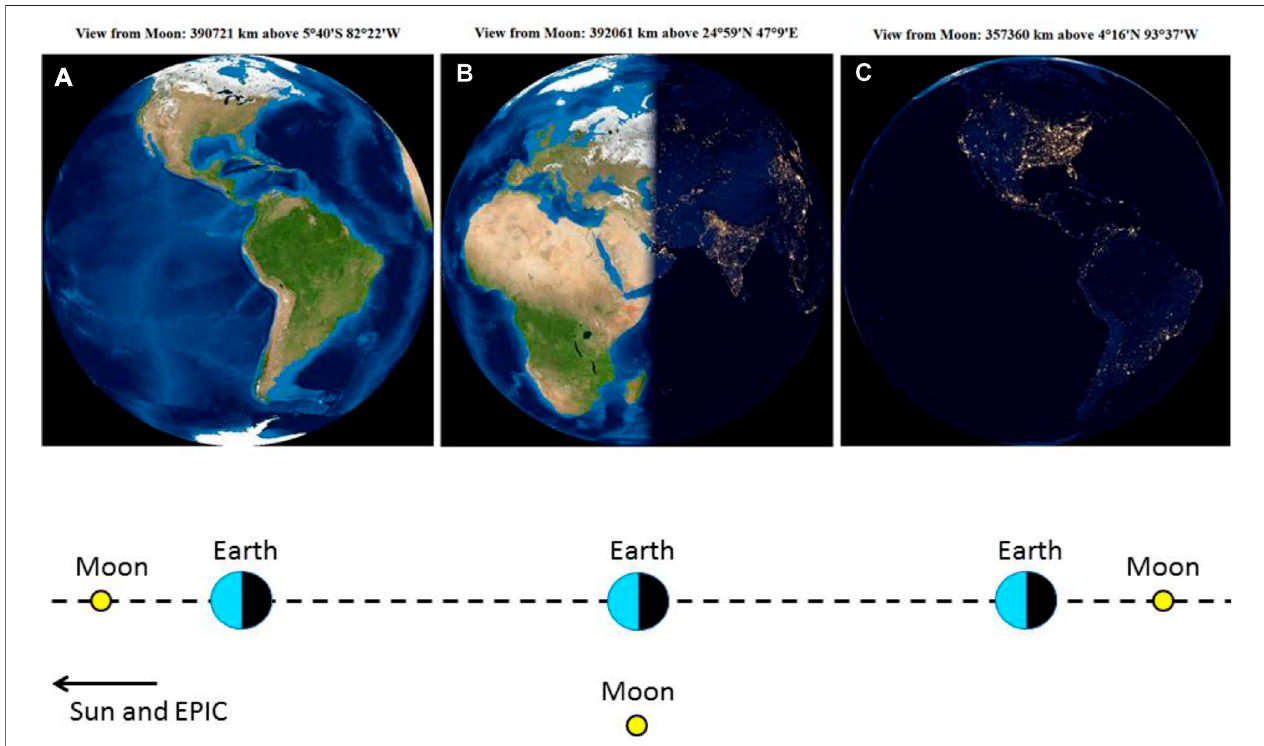
FIGURE 2 | View of the Earth from the Moon at three points of the lunar orbit with phase angles of (A) 0 ° , (B) 90 ° , and (C) 180 ° . The image of the Earth shown here and in Figure 3 was obtained by J. Walker based on MODIS/TERRA and Suomi/NPP images (Walker, 2021).